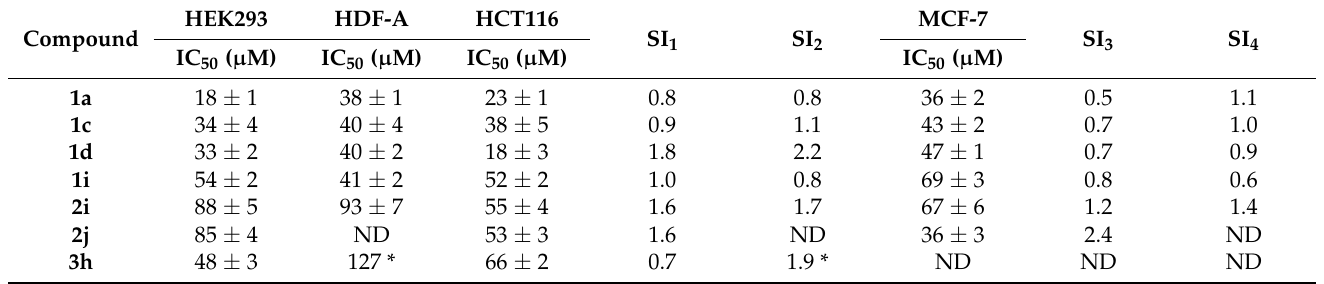
Table 1. Half-maximal inhibitory concentration (IC50) and selectivity index (SI) calculated for tested compounds. Data are presented as the mean ± standard error of the mean